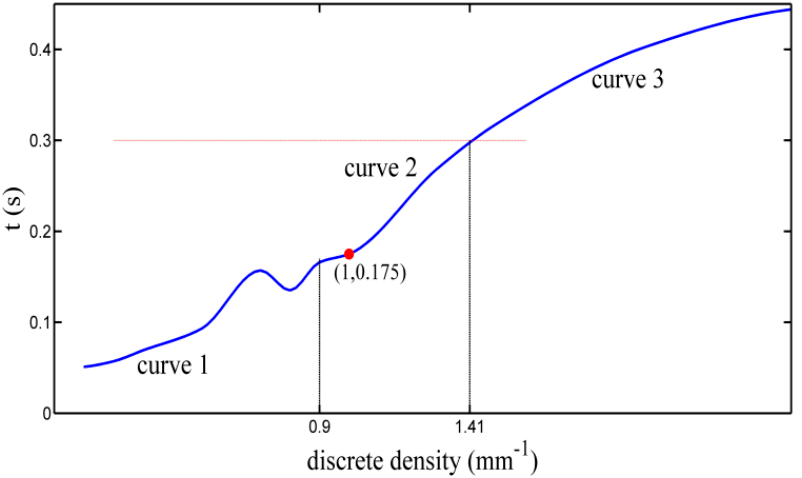
Figure 10. Relationship between time cost ( t ) and discrete density (n/L).